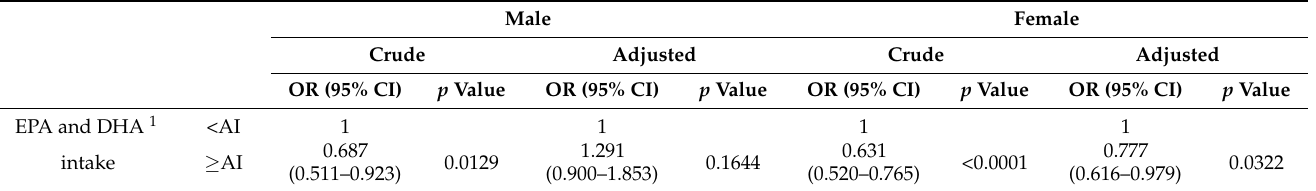
Table 4. Adjusted odd radios and 95% confidence intervals of low grip strength risk by EPA and DHA